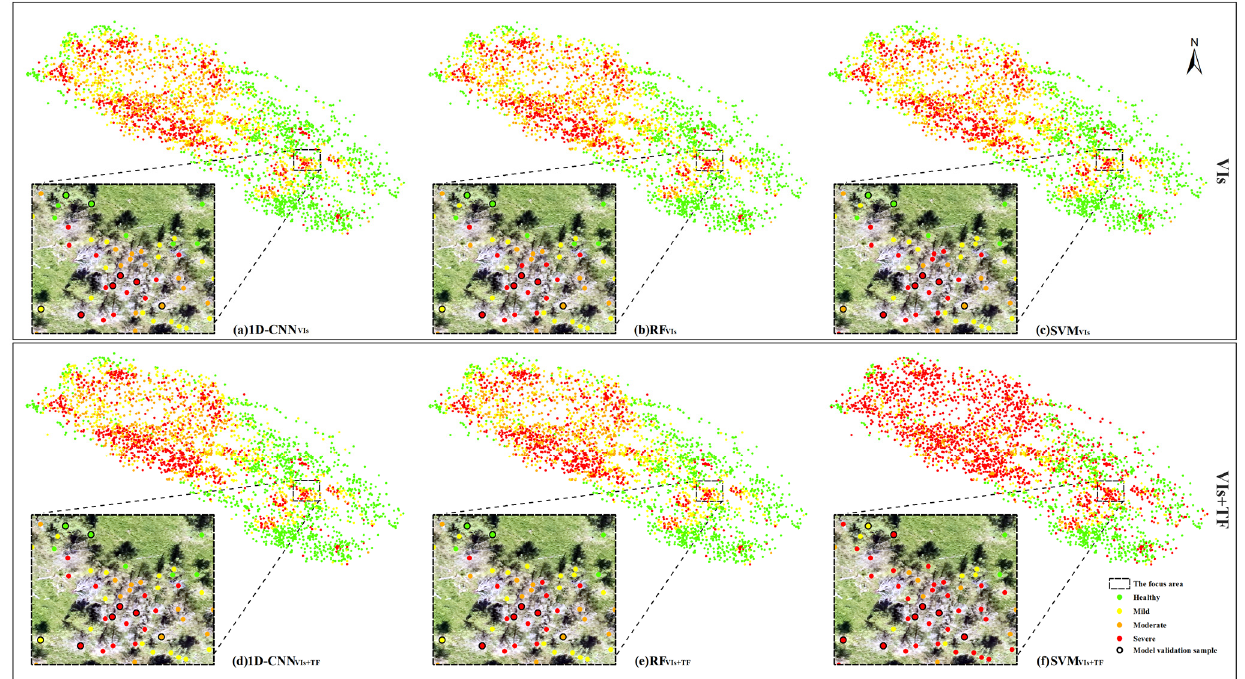
Figure 7. Identification of different levels of damage in EJD stands, where ( a – c ) are VIs models and ( d – f ) are combined Vis + TF